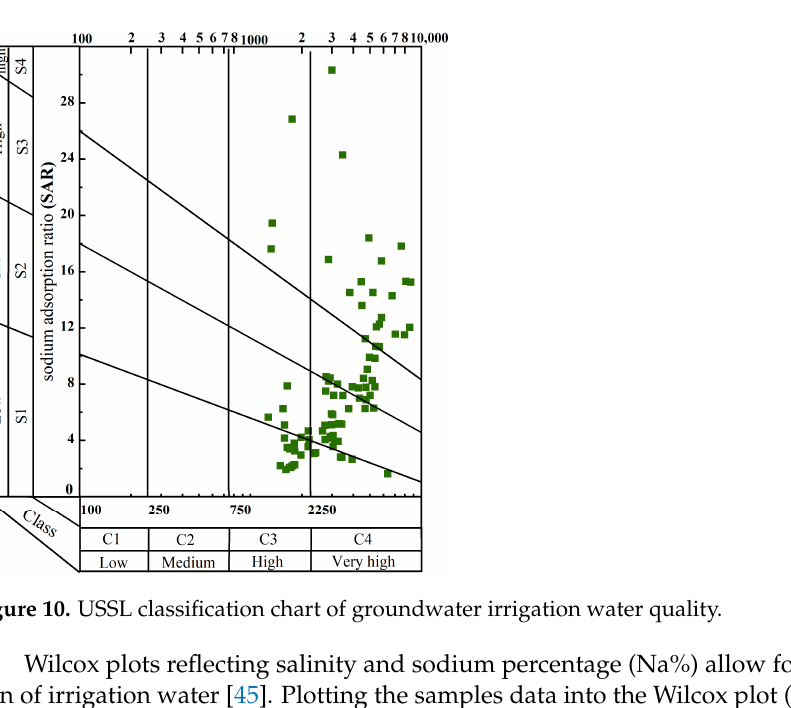
Figure 12. Doneen diagram of groundwater irrigation water quality.